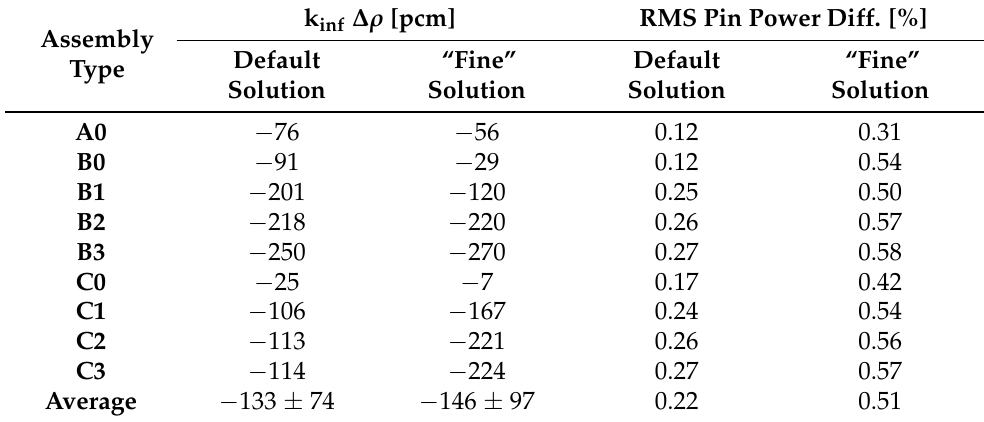
Table 4. Comparison of default and “fine”